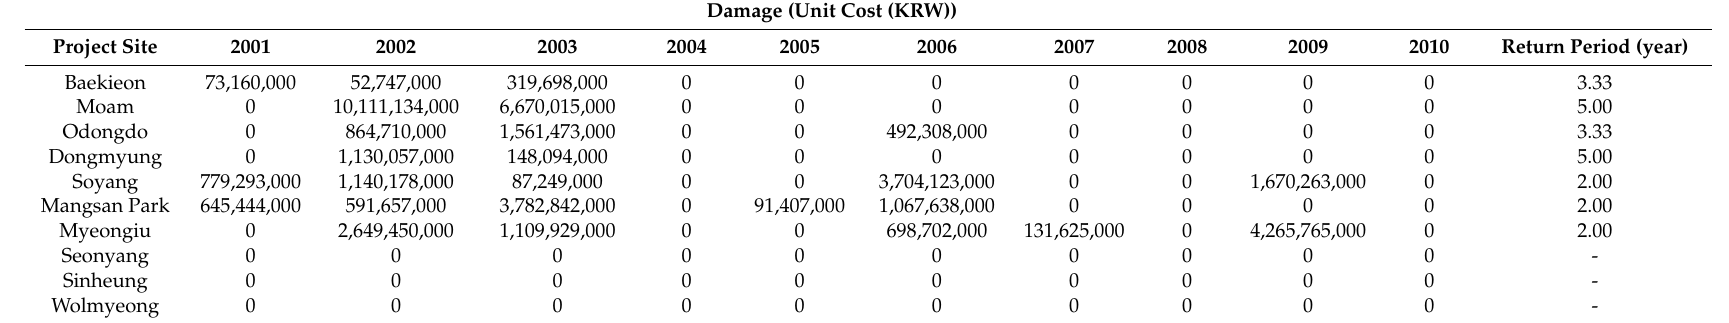
Table 8. Return period of project site